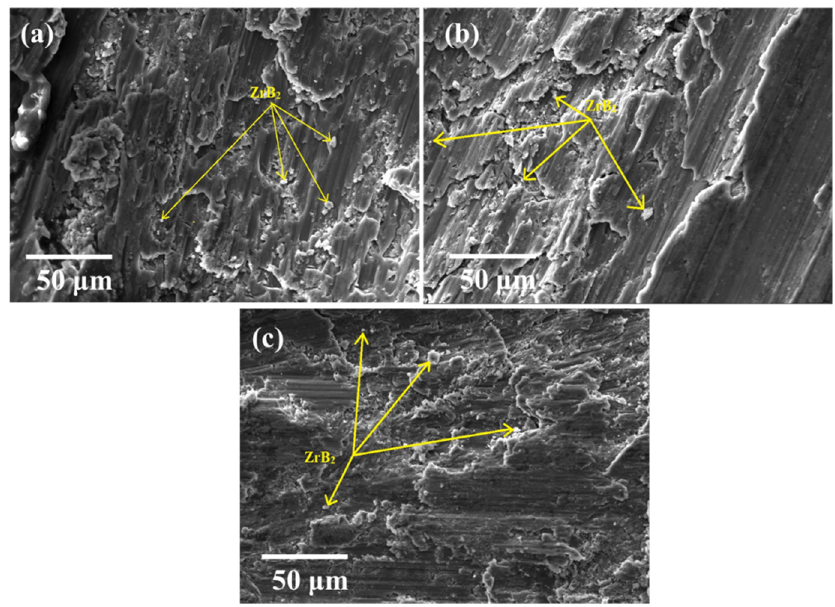
Figure 2. SEM micrograph of ADC12/ZrB 2 in situ composites containing ( a ) ZrB 2 3%; ( b ) ZrB 2 6% ZrB 2; ( c ) 9% ZrB 2 .